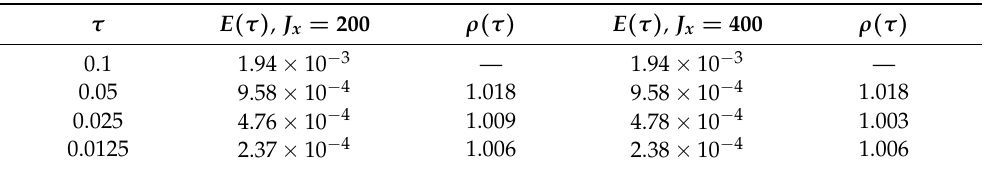
Table 2. Modified errors (cid:101) E ( τ ) and experimental convergence rates ρ ( τ ) for the discrete solution of the BE scheme (10) for a sequence of time steps τ